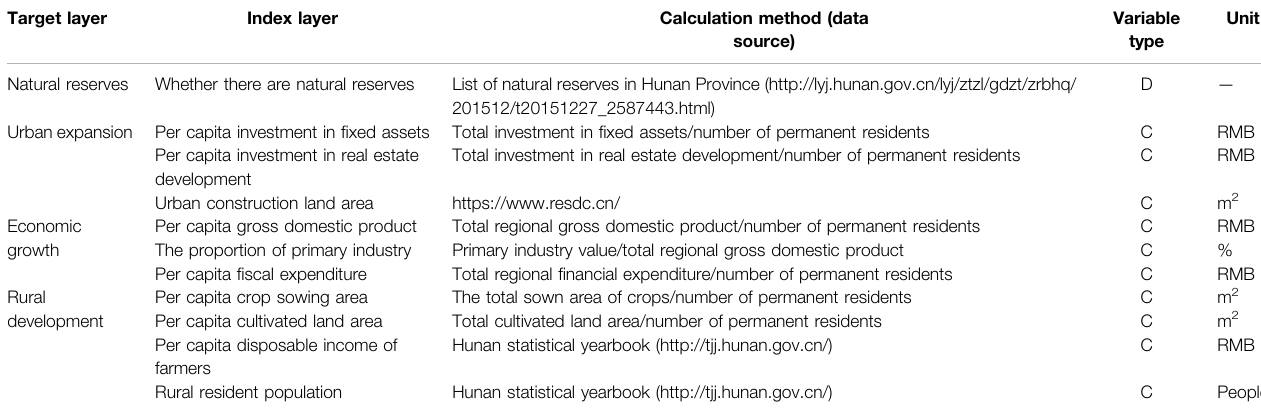
TABLE 1 | Factors in fl uencing